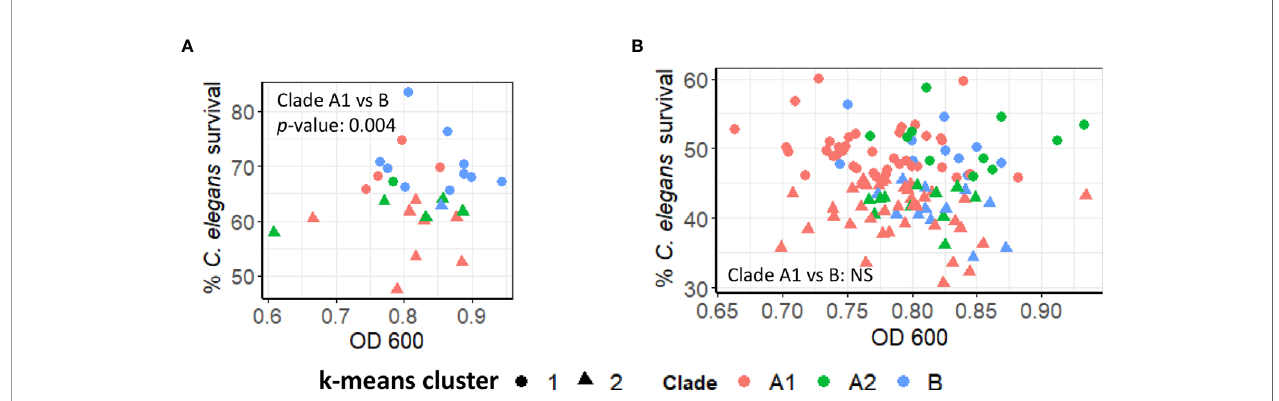
FIGURE 5 | Pathogenicity of E. faecium from distinct clades does not differ signi fi cantly. (A, B) Pathogenesis of (A) preliminary (~30) or (B) all available (~120) E. faecium strains belonging to Clade A1, A2, or B In (A, B) , C. elegans survival (y-axis) were plotted against E. faecium OD 600 (x-axis). Clustering was performed with ‘ kmeans ’ function (R v4.0.3). All panels show pooled results from three biological replicates. p -values were determined from Student ’ s t -test and are indicated